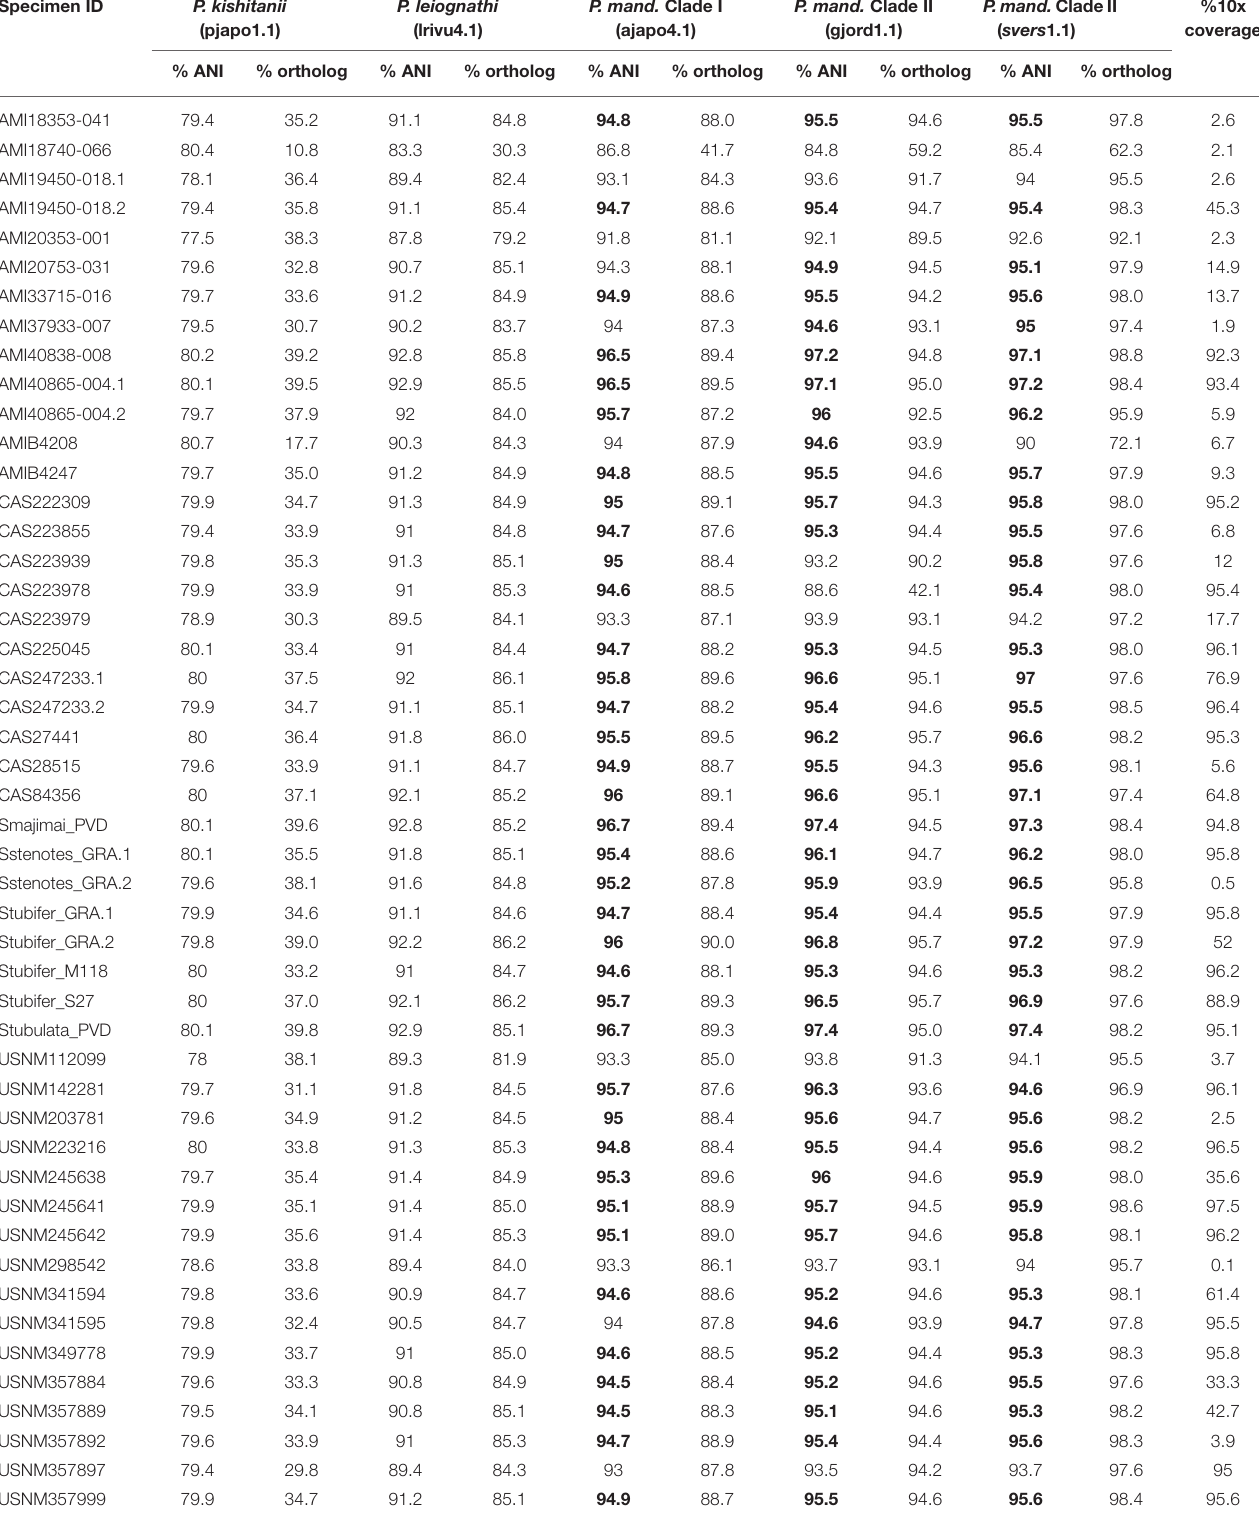
TABLE 2 | Average nucleotide identities (% ANI) of the consensus sequences of the light organ symbionts from the Siphamia specimens sampled in this study relative to several symbiotic Photobacterium species: P. kishitanii (pjapo1.1), P. leiognathi (lrivu4.1), P. mandapamensis ( P. mand. ), Clade I (ajapo4.1), and Clade II (gjord1.1,